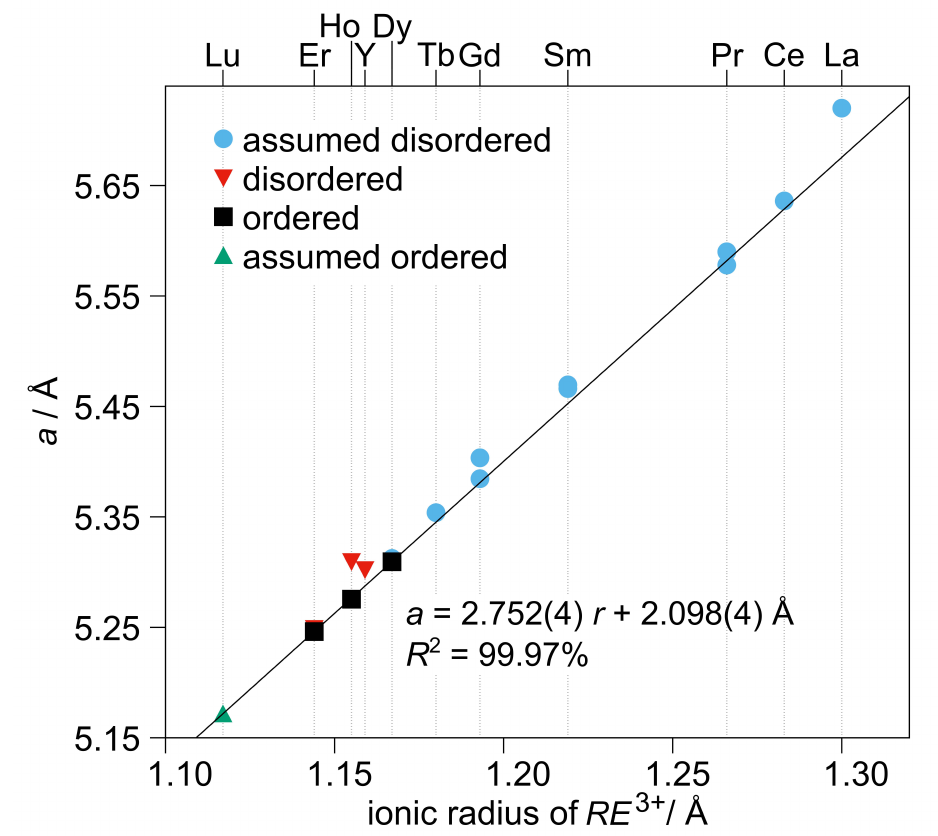
Figure 7. Correlation of lattice parameters of cubic rare earth hydride oxides with anion-ordered or -disordered structure verified by neutron diffraction, or yet unknown and assumed ordered or disordered anionic substructure with the ionic radius of the eightfold coordinated RE 3+ ion [64]. The error bars are smaller than the displayed symbols. Black line: linear regression of anion- ordered RE HO compounds DyHO, HoHO, and ErHO. Values for RE = La, Ce, Pr [31,32], Sm